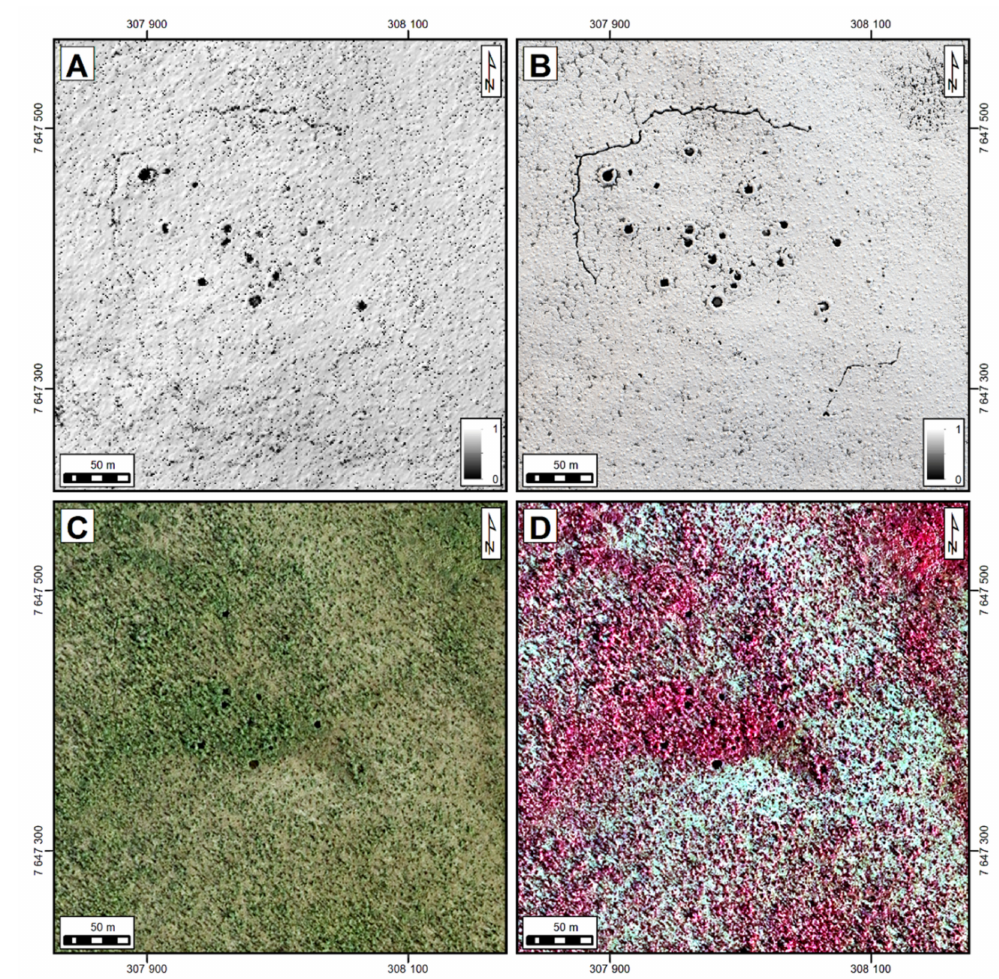
Figure 5. The remote sensing datasets used in the analyses: a remote German military outpost at Hirvasvuohppi visualized with ( A ) ALS-0.5p (1-m DEM, visualized with SVF+Multi-HS). ( B ) ALS-5p (0.2-m DEM, SVF+Multi-HS) [17]. ( C ) Natural color orthophoto. ( D ) Color-infrared orthophoto. (NLS, CC-BY-4.0; EPSG:3879 ETRS89/GK25FIN). (Illustration: Oula